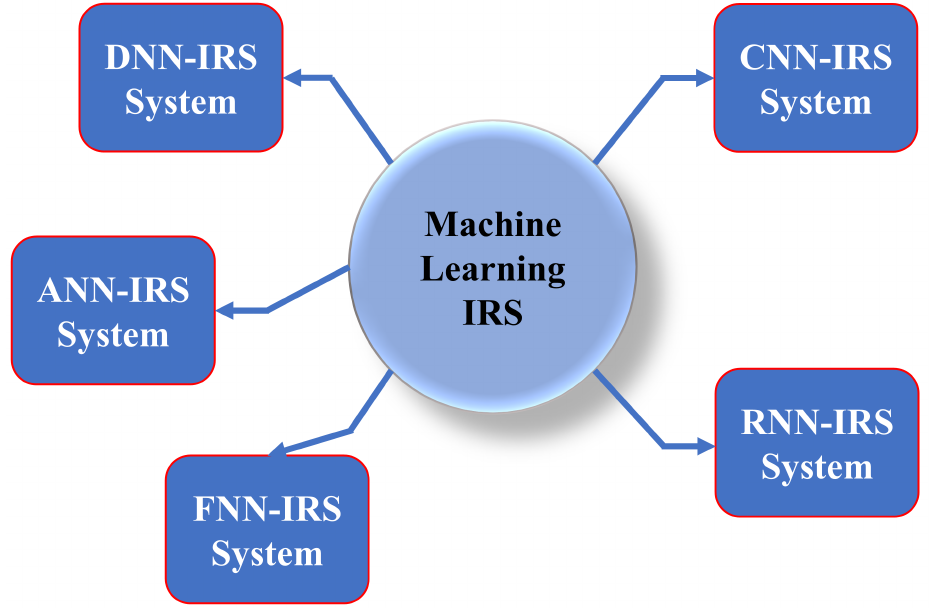
Figure 6. Taxonomy of ML-based IRS